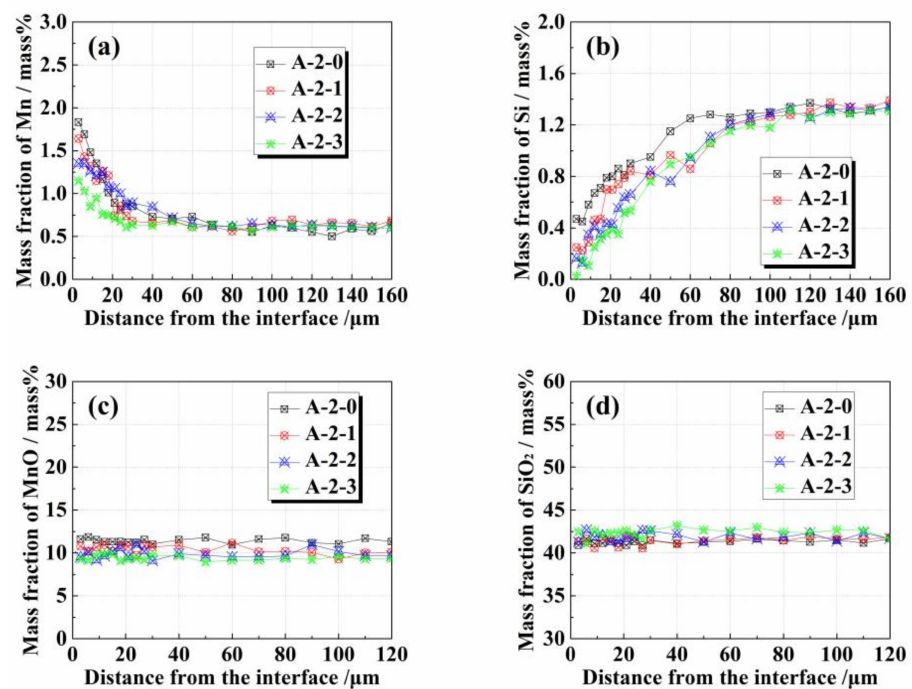
Figure 9. Composition changes in the alloy and oxide near the interface in A-2- x diffusion couples after isothermal heating at 1473 K for 10 h: ( a ) Mn; ( b ) Si; ( c ) MnO; ( d ) SiO 2